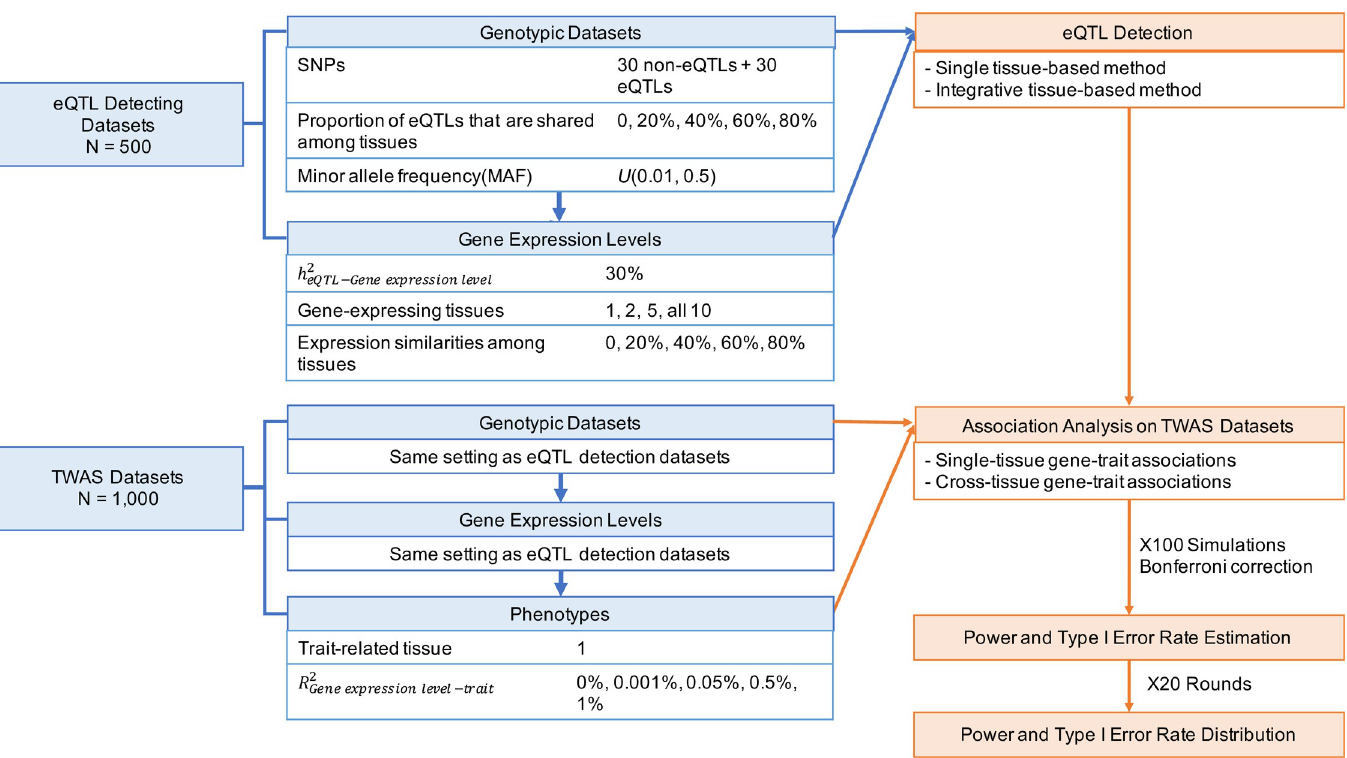
Fig 1. Cross-tissue TWAS simulation scheme. With the simulation parameters, we were able to generate SNP-gene-trait relations of varied tissue specificity backgrounds. In each replication, simulated datasets were divided into an eQTL detection dataset and a TWAS dataset. The former was used to identify eQTLs using different eQTL detection methods and the sample size was equivalent to that of GTEx. The detected eQTLs were then passed, separately, to the TWAS dataset to assist gene-level association tests. The TWAS dataset sample size was equivalent of that of the ACTG clinical trial dataset. Two types of gene-level association approaches estimated and ascribed p-values to the simulated gene-trait relations. In each replication, we simulated 100 different SNP-gene-trait pairs for one single point estimation of TWAS gene prioritization performance. All association p-values had been adjusted for the number of genes and tissues in each replication. 20 independent replications were conducted to obtain the distribution of TWAS performance statistics.